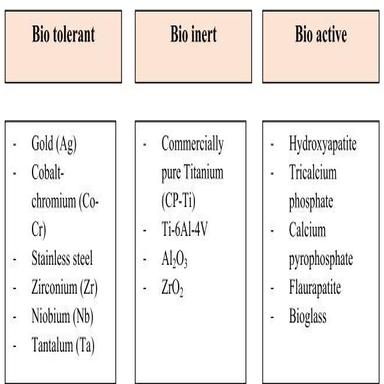
Categorization of implants on the basis of its basic behaviour or reaction.